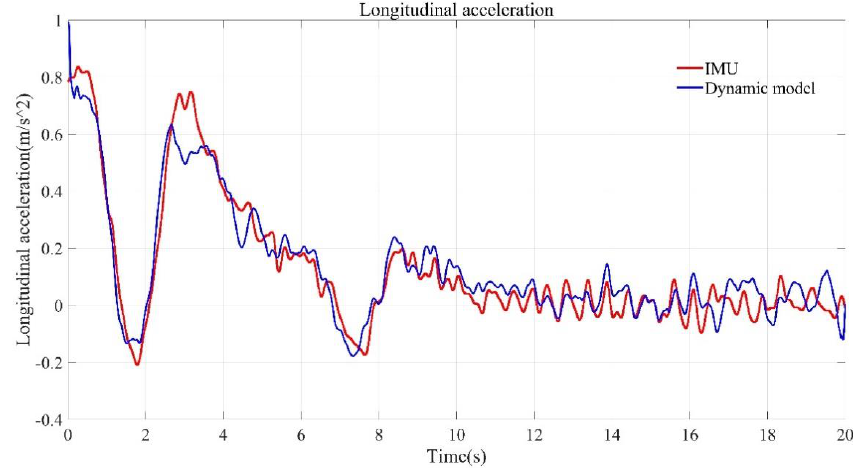
Figure 17. Comparison of the longitudinal acceleration results between the vehicle dynamics model using estimation results and the real vehicle test.